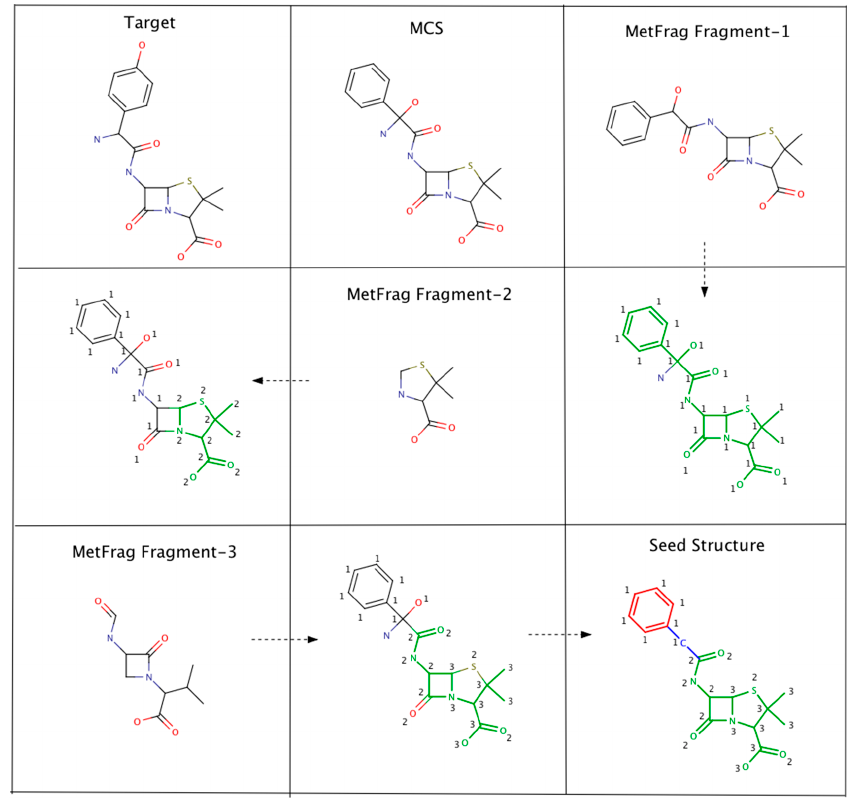
Figure 2. An example illustrating the steps involved in Algorithm 3–3. MCS atoms that matched MetFrag fragments are colored in green. The numbers indicate the number of times a particular MCS atom matched a MetFrag